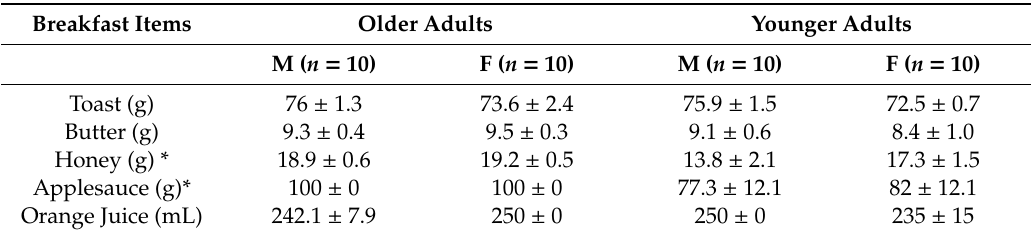
Table 1. Breakfast items consumed by the study